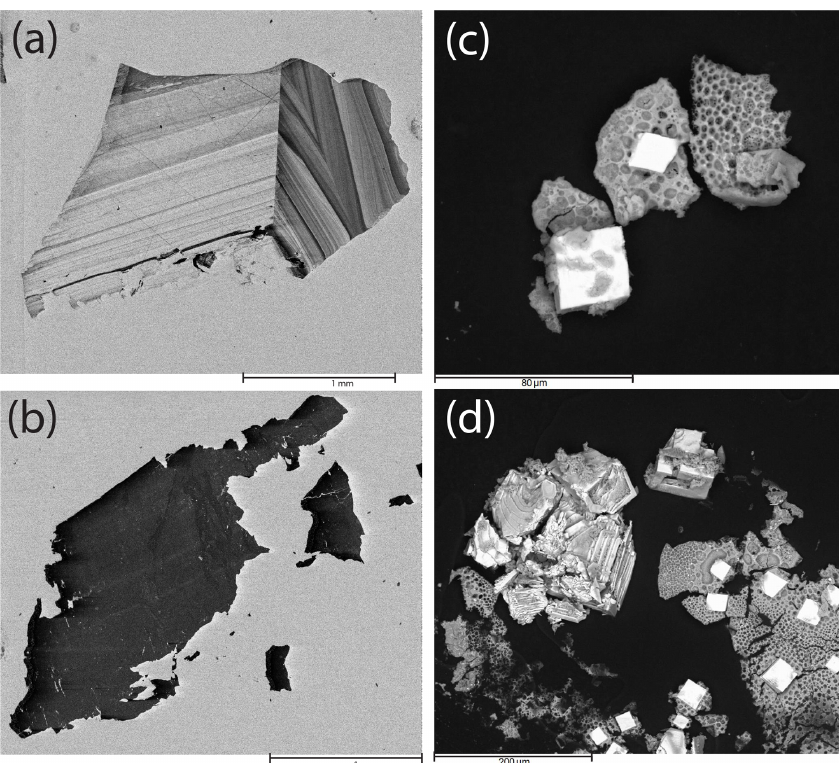
Figure 1. (a) Representative CL image of cassiterite from Cligga Head used for decomposition experiments and geochronology. (b) Rep- resentative CL image of the Casnig cassiterite used for decomposition experiments. (c, d) SEM images of the precipitate formed after drying down the HBr leachate after cassiterite decomposition. Light-coloured crystals are tin bromide crystals; the “spongy” texture contains bromides of Fe, Nb and